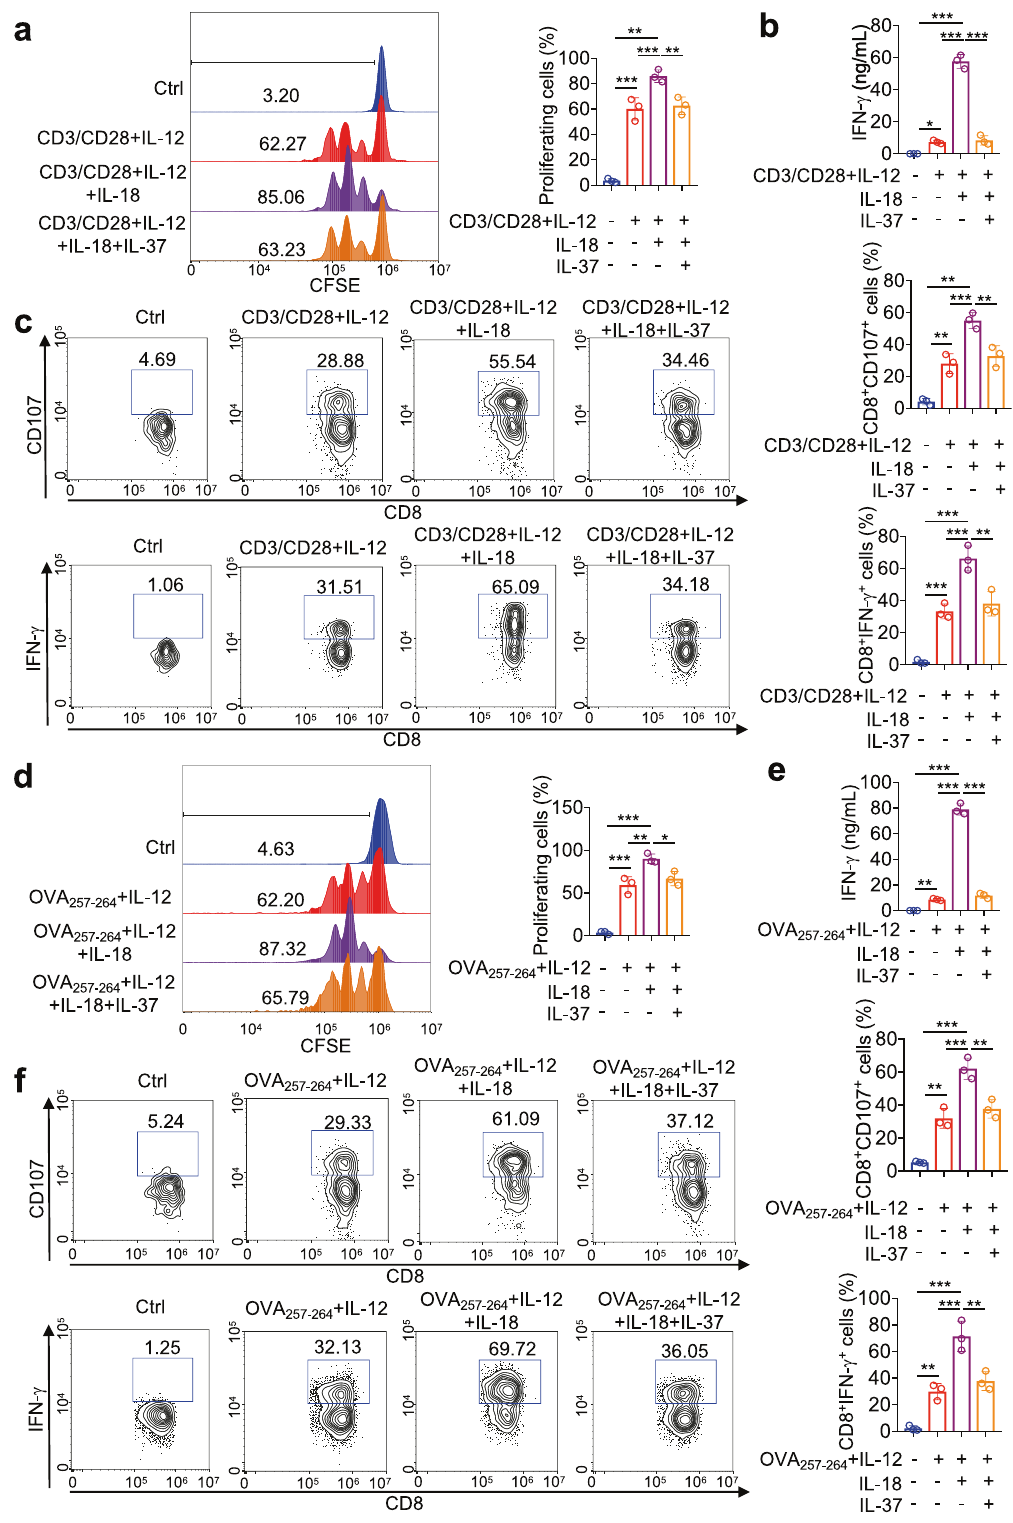
may be more closely match IL-37 expression patterns in homo sapiens, because previous studies indicated that IL-37 was expressed in intestinal epithelial cells and as well as in fl ammatory cells in human colon tissues. 49 Our fi ndings have shown that IL-37 can inhibit IL-18-mediated signaling. In DSS model, IL-18 secretion